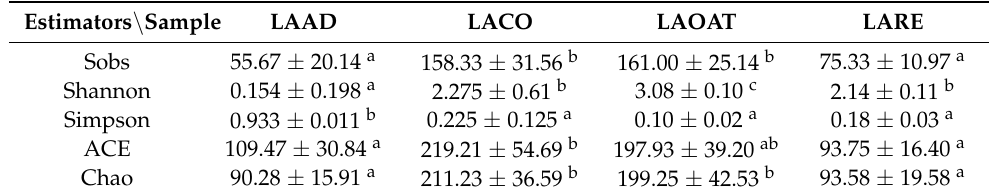
Table 1. Comparison of alpha diversity indices (Mean ± SD) among different groups. Different letters indicate significant differences across treatments ( p < 0.05).